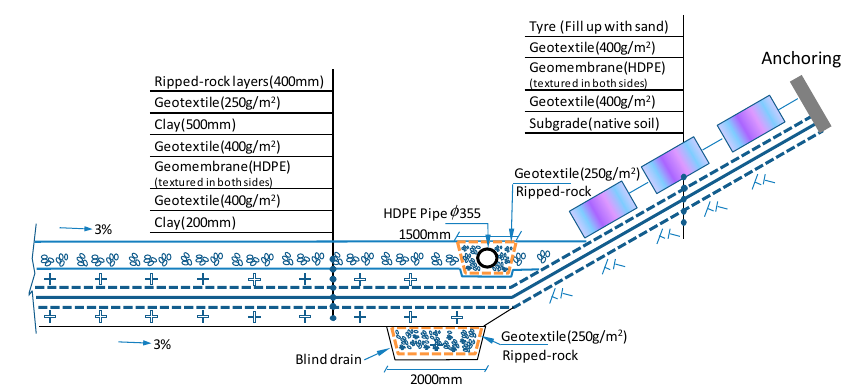
Figure 3. Structural drawing of the composite liner system.